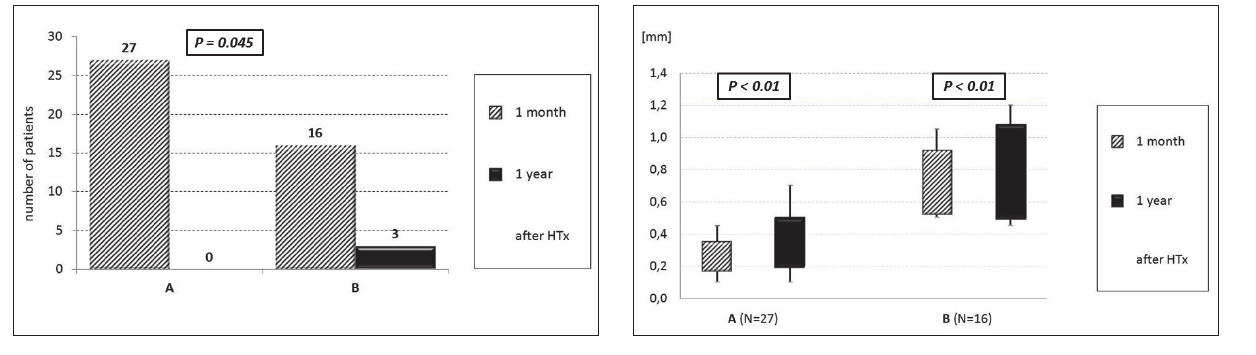
Fig. 2. Correlation between initial MIT and its progression over one year